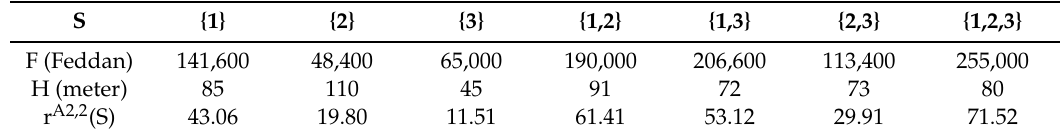
Table 12. Characteristic Function Values for game r A2,2 .